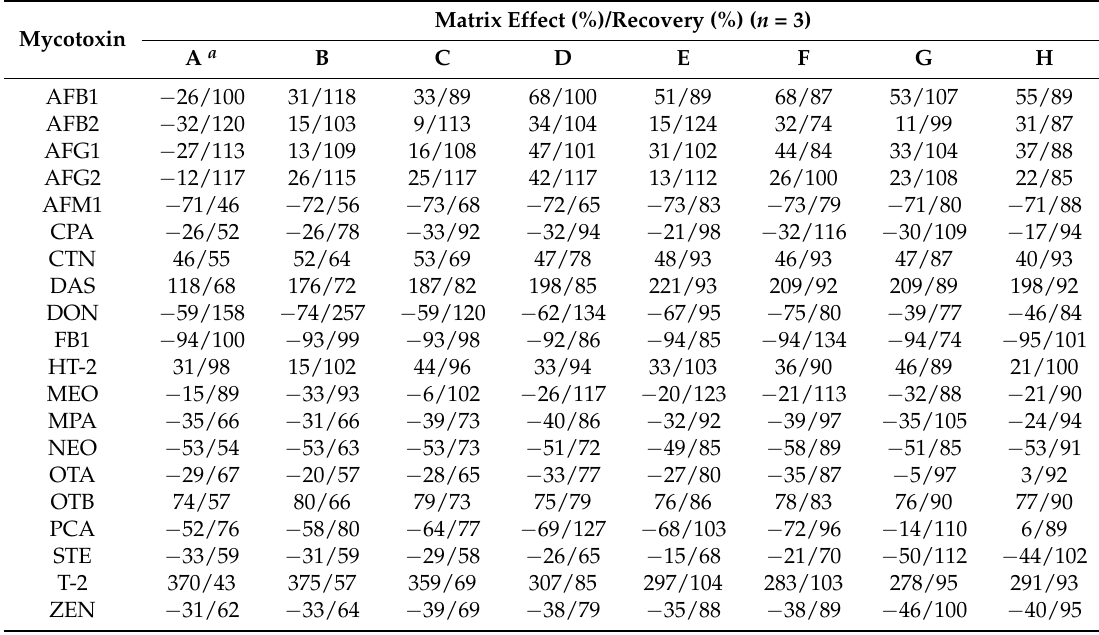
Table 3. Matrix effect and recovery percentage obtained by applying various amounts of salt.